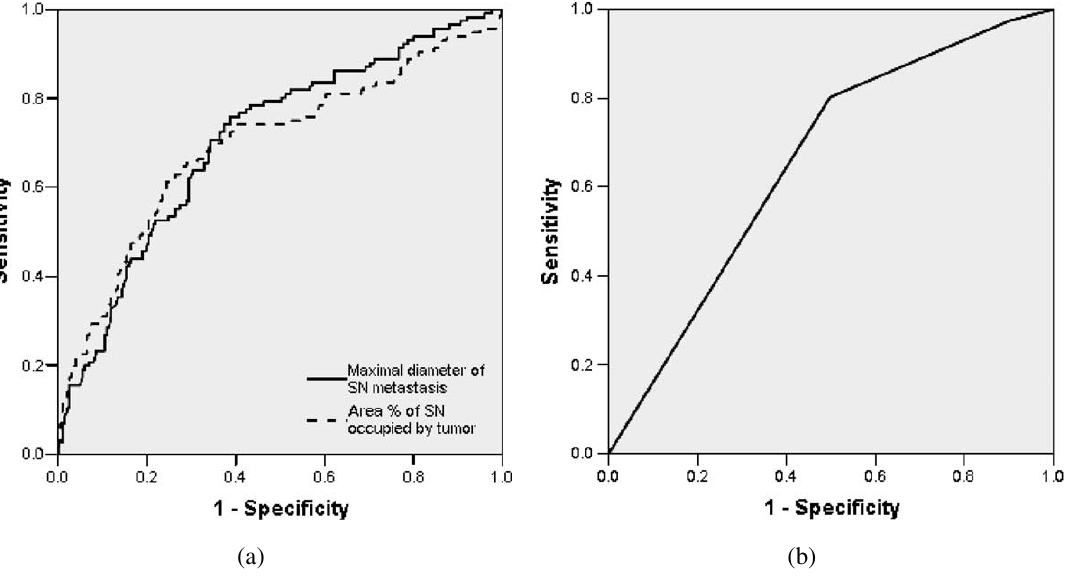
Fig. 1. ROC curves for the discriminative power for SN positive patients with and without second echelon lymph node metastases of the features area % of the SN occupied by tumor, the Maximal diameter of SN tumor deposits (a) and the UICC classification (b). The larger the area under the curve, the more accurate is the prediction of second echelon lymph node